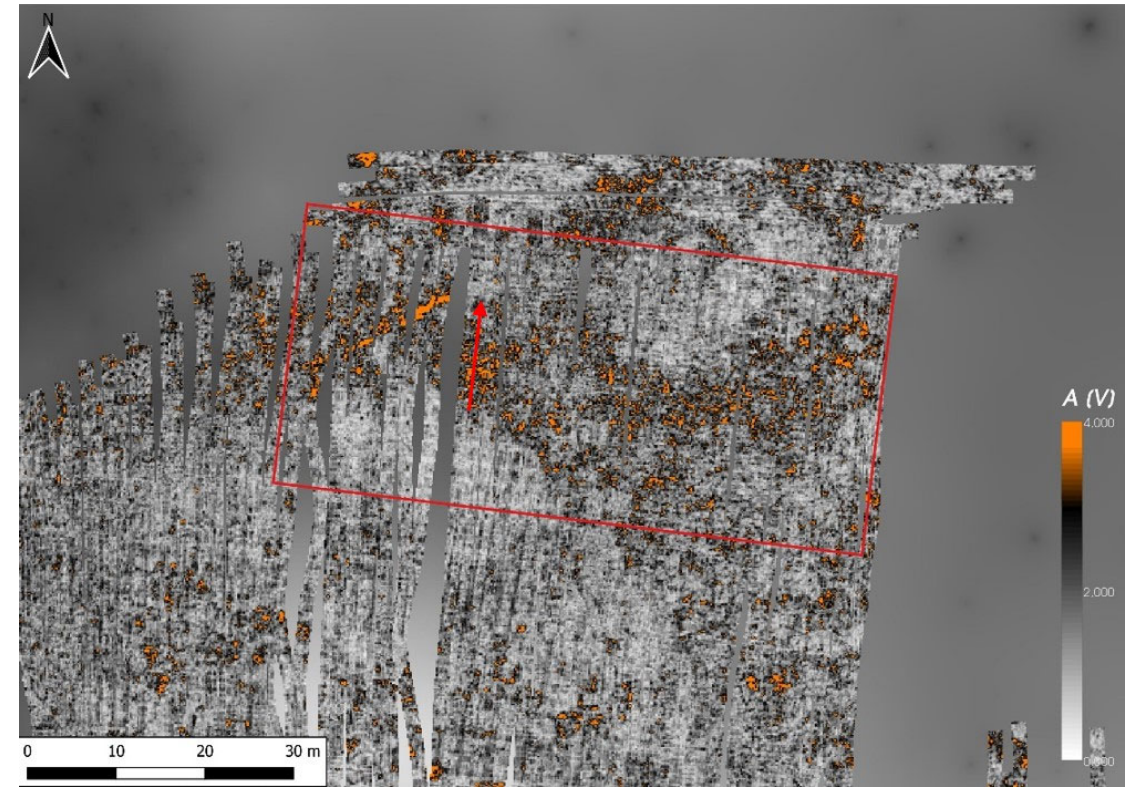
Figure 3. Detail of the northern Area 1. On the right, (red square) the set of alterations consisting of the rectangular structure with its subdivisions. On the left, the sign where the alignment is interpreted, possibly a wall delimiting the area. The red arrow indicates the area chosen for the radargram analysis (Figure 4).